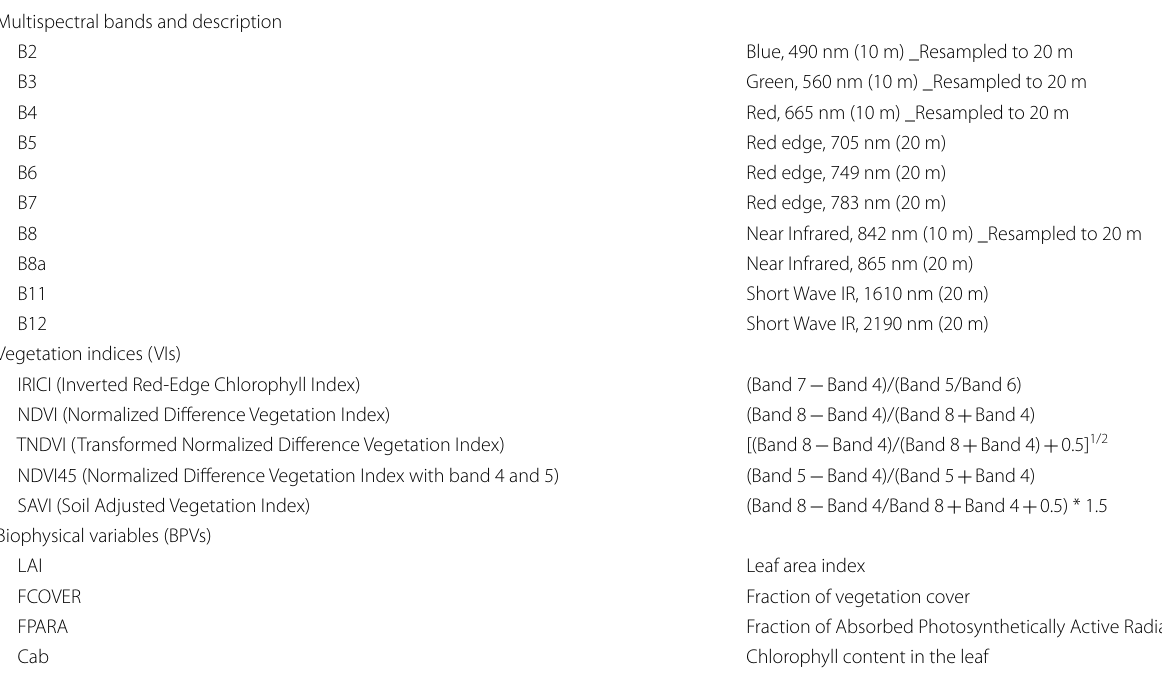
Table 2 List of selected multispectral bands, derived VIs and BPVs from Sentinel-2 image Multispectral bands and